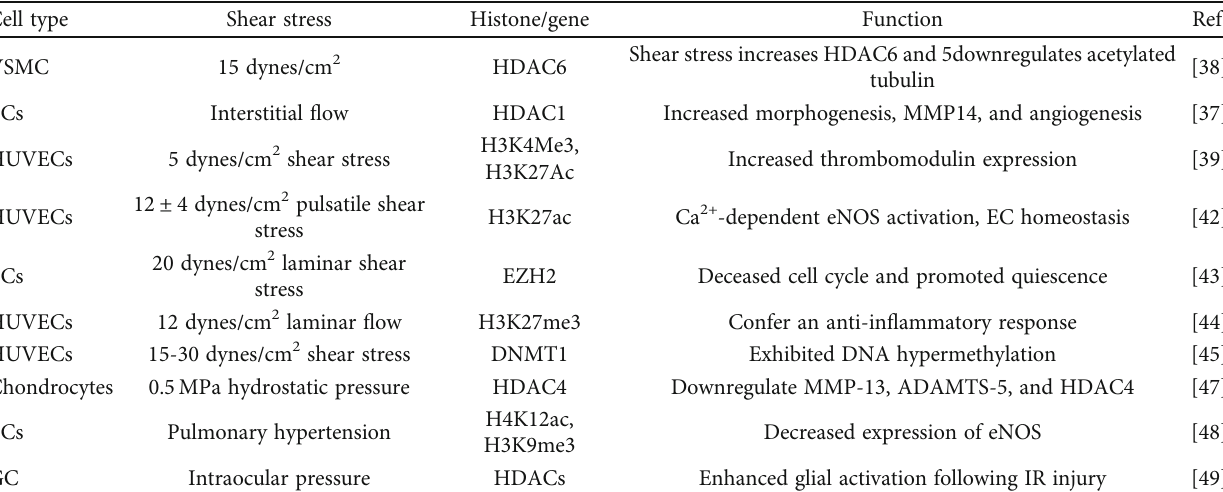
Table 3: Examples of shear stress-regulated histone modi fi